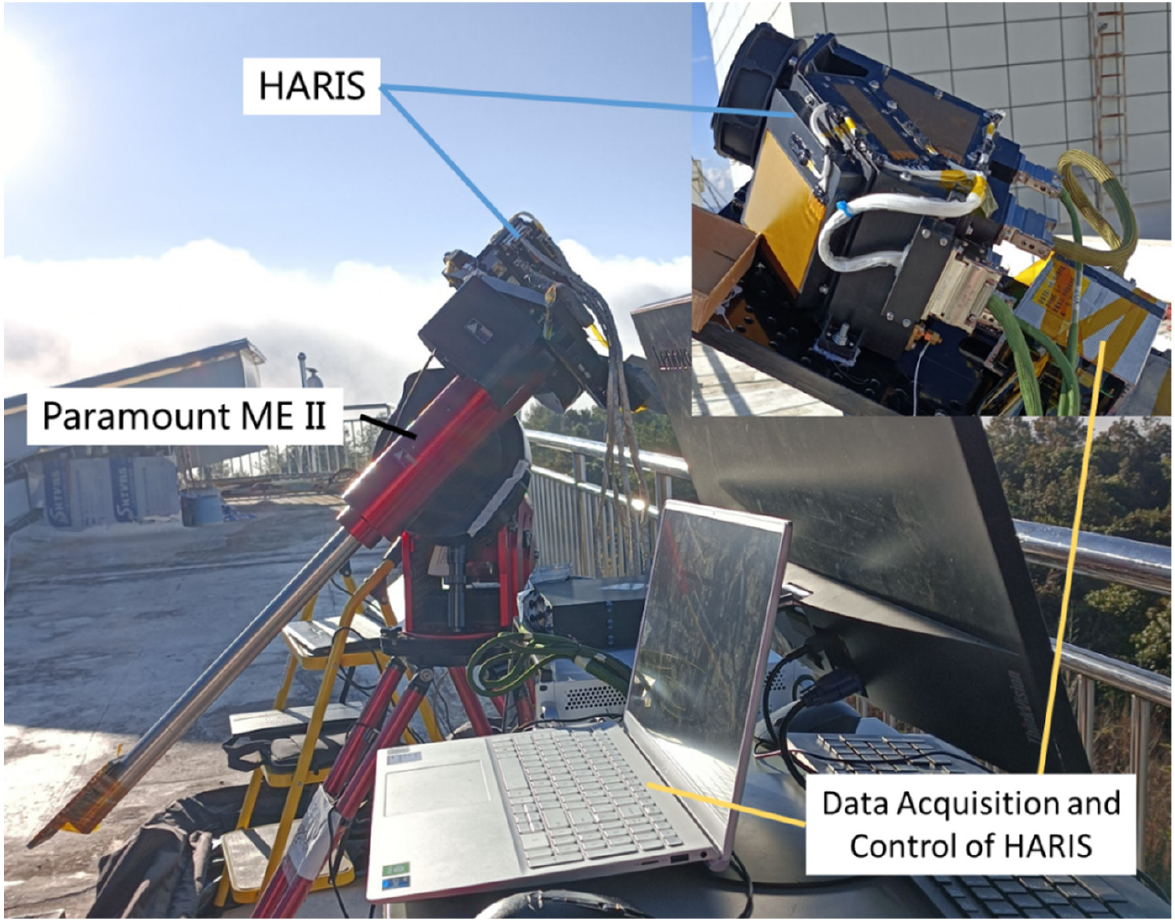
Figure 13. Photograph of the setup that was used for the field tests.